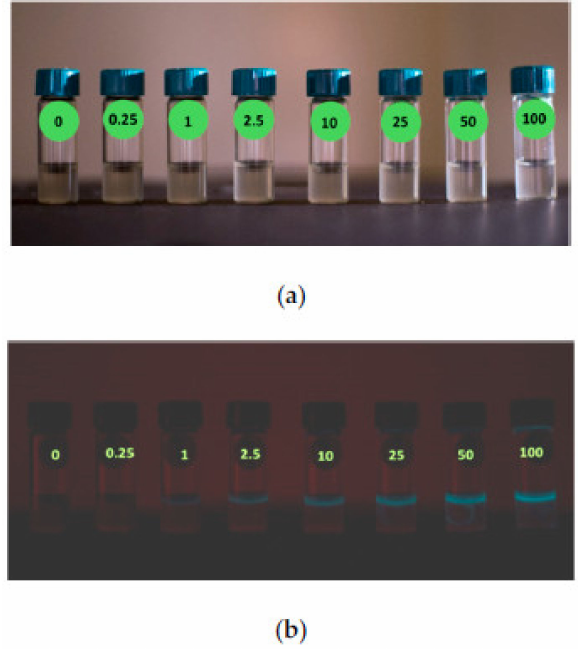
Figure 12. Photo images of the bioluminescence of the E. coli bacteria in mercury ion-treated water under different conditions: ( a ) light; and ( b ) no light (reprinted from Ref. no. [106], copyright 2019,